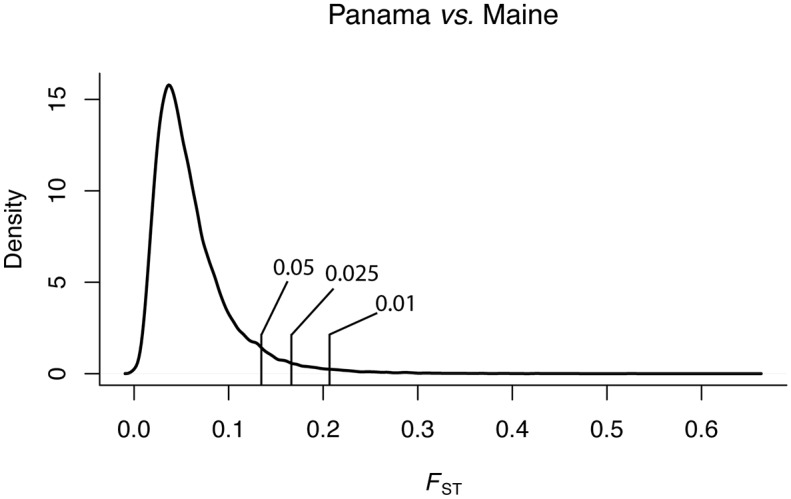
Density of FST estimates from 1-kb windows between Panama and Maine populations.The 1%, 2.5%, and 5% tail cutoffs are indicated with hash marks.